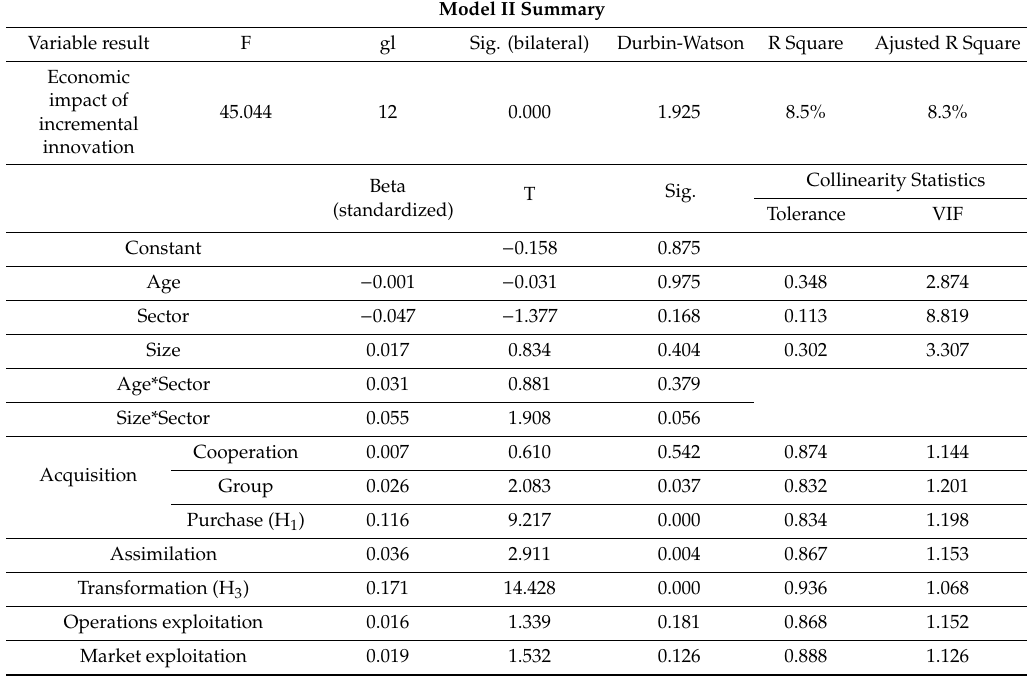
Table 4. Knowledge absorptive routines and the economic impact of incremental